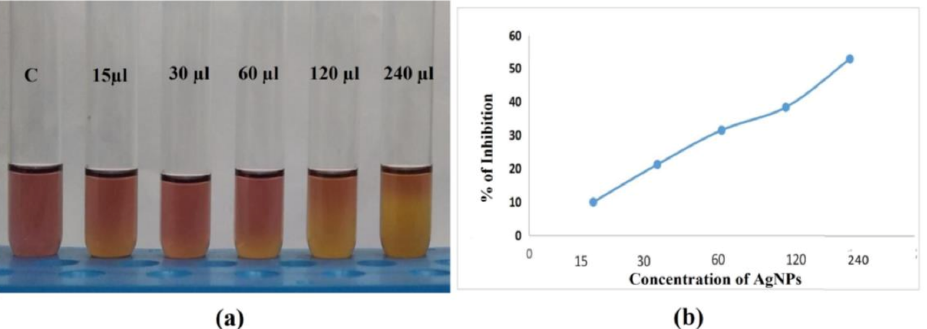
Figure 12. Antioxidant activity of synthesized Silver Nanoparticles of different concentrations. ( a ) The results of 0 µ L (control C), 15 µ L, 30 µ L, 60 µ L, 120 µ L, and 240 µ L concentrations, as measured by the DPPH assay, formed a linear graph ( b ), proving that as the concentration of AgNp increases, scavenging activity also increases from 9.9 to